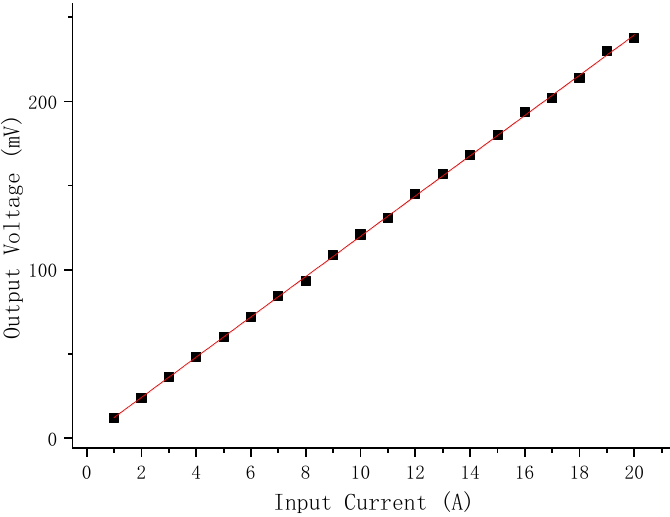
Figure 21. DC input-output curve of the open contactless composite broadband current sensor.